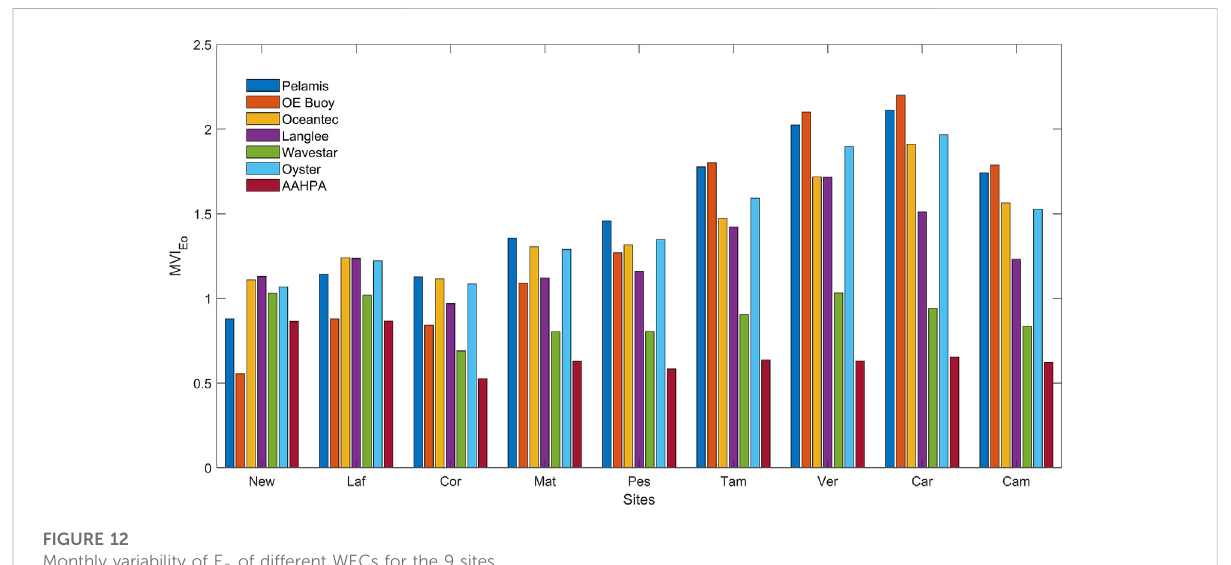
FIGURE 12 Monthly variability of E o of different WECs for the 9 sites.